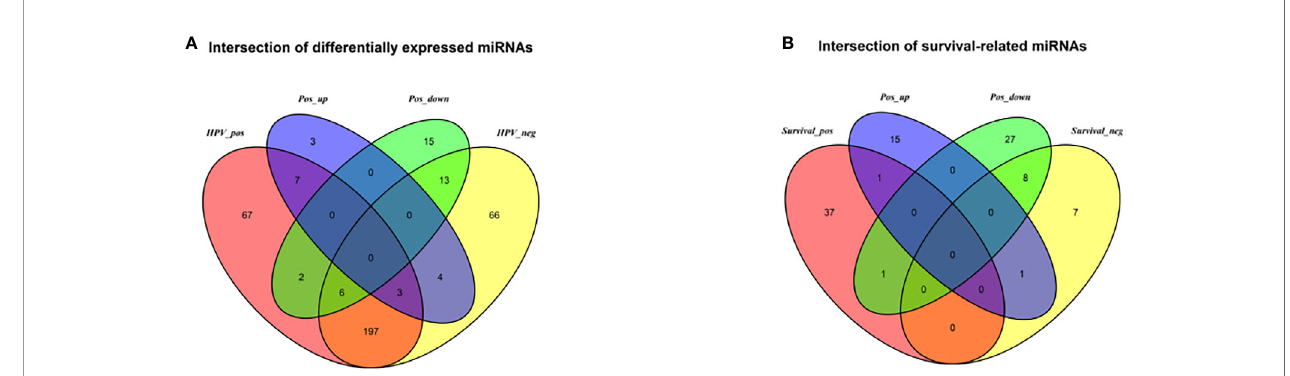
FIGURE 2 | (A) Venn diagram of differentially deregulated miRNA sequences across groups; (B) Venn diagram of survival-related miRNAs. HPV_pos = differentially expressed miRNAs between HPV+ and normal-adjacent tissues; HPV_neg = differentially expressed miRNAs between HPV- and normal-adjacent tissues; Pos_up = up-regulated miRNAs compared HPV+ with HPV- tissues; Pos_down = down-regulated miRNAs compared HPV+ with HPV- tissues; Survival_pos = survival-related miRNAs in HPV_pos; Survival_neg = survival-related miRNAs in HPV_neg.